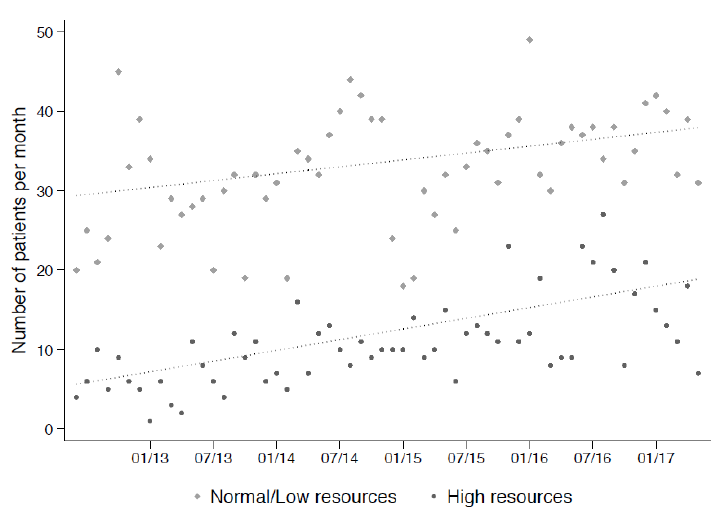
Figure 2. Number of alcohol intoxications per month over the course of the study, according to type of resource consumption.